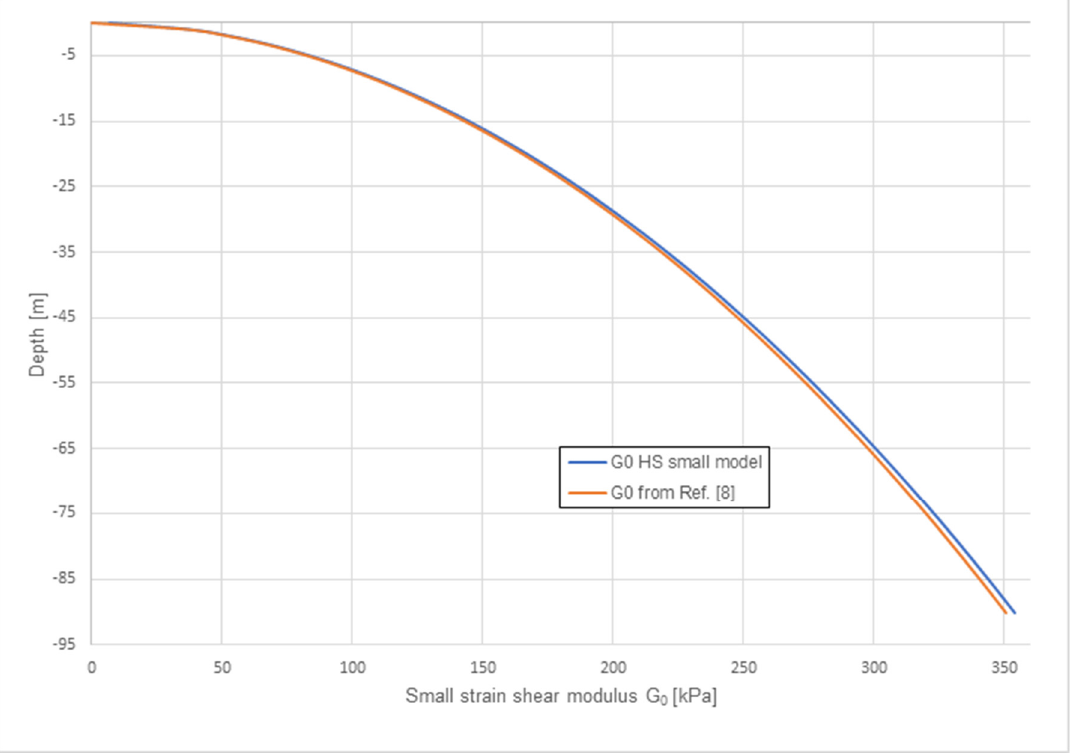
Figure 2. G 0 -profile from the HSsmall model, in comparison with [9].